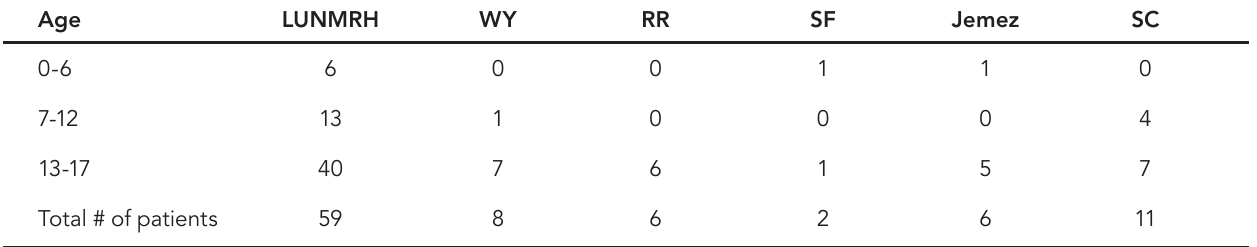
Table 10. The number of pediatric and adolescent outpatients per location for